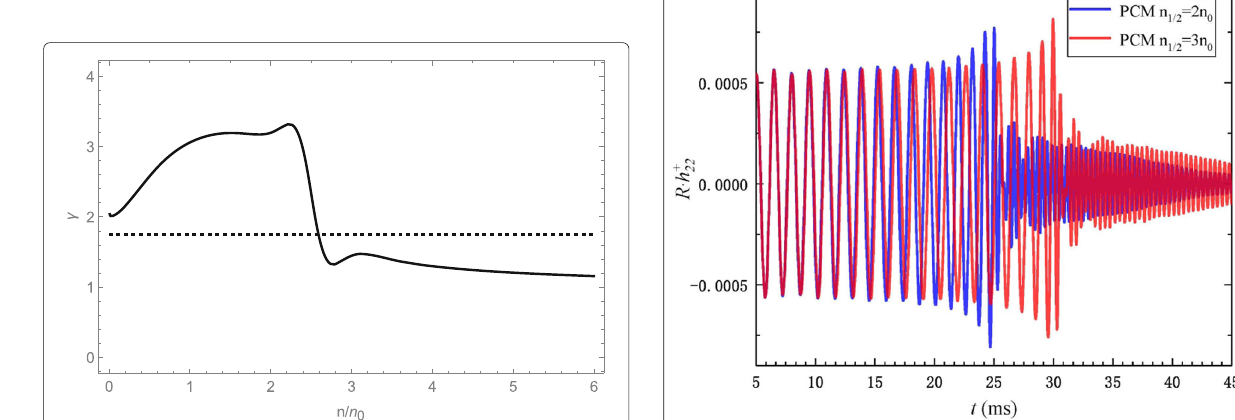
Fig. 13 Dominant mode of the GW strain from the BNS star system with equal masses 1.5 M (cid:3) stars. For a detailed explanation, see Ref.